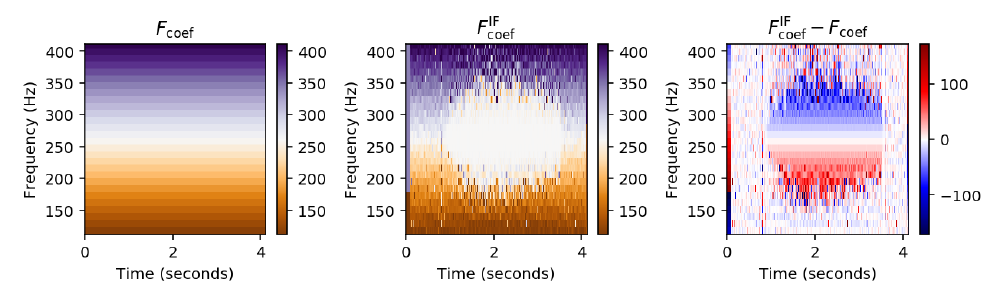
Figure 22. Interpretation of time–frequency bins of an STFT as specified by the (frame-independent) frequency values F coef ( k ) and the (frame-dependent) instantaneous frequency values F IF bin offset (specified in Hertz) is given by F IF